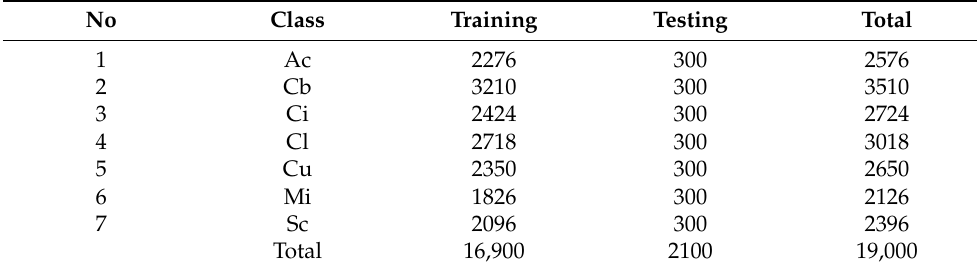
Figure 10. Example images from the ASGC dataset: ( a ) altocumulus (Ac); ( b ) cumulonimbus (Cb); ( c ) cirrus (Ci); ( d ) clear (Cl); ( e ) cumulus (Cu); ( f ) mixed (Mi); ( g ) stratocumulus (Sc). Table 4. Training and testing samples for the GCD dataset.